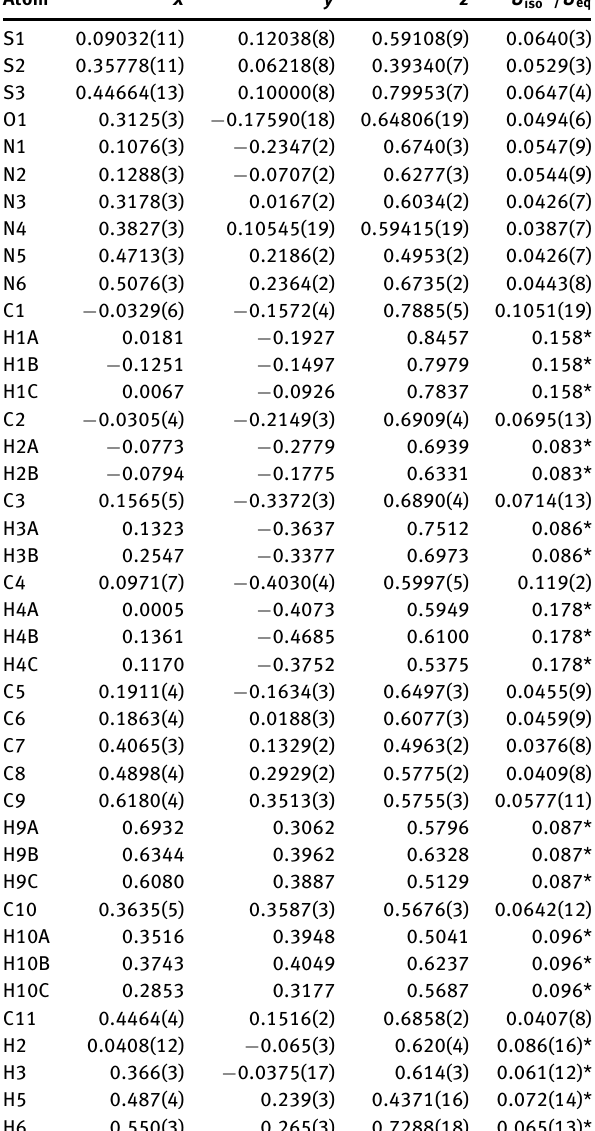
Table 2: Fractional atomic coordinates and isotropic or equivalent isotropic displacement parameters (Å 2